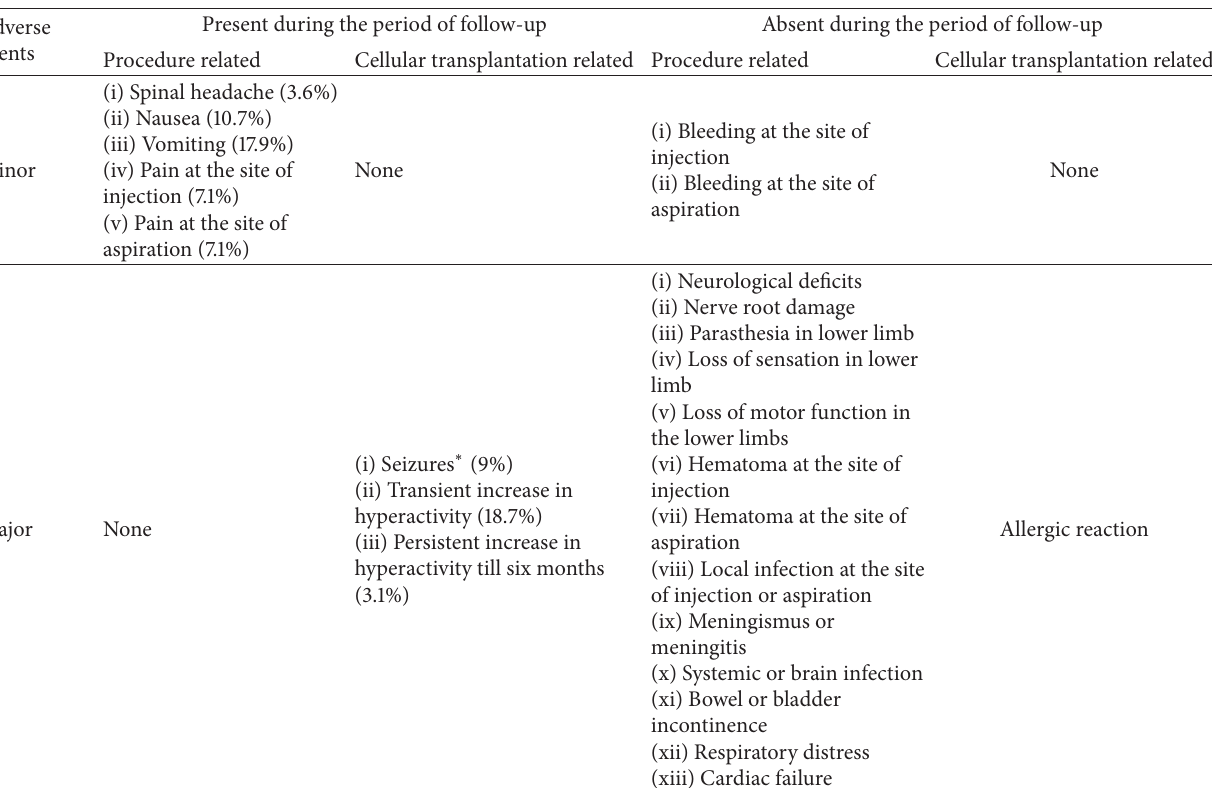
Table 4: Adverse events monitored over the entire period of follow-up of 26